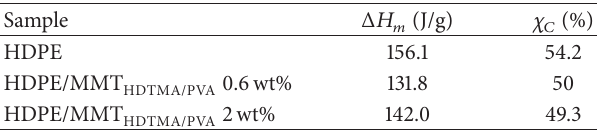
Table 1: Fusion enthalpy and crystalline degree of the